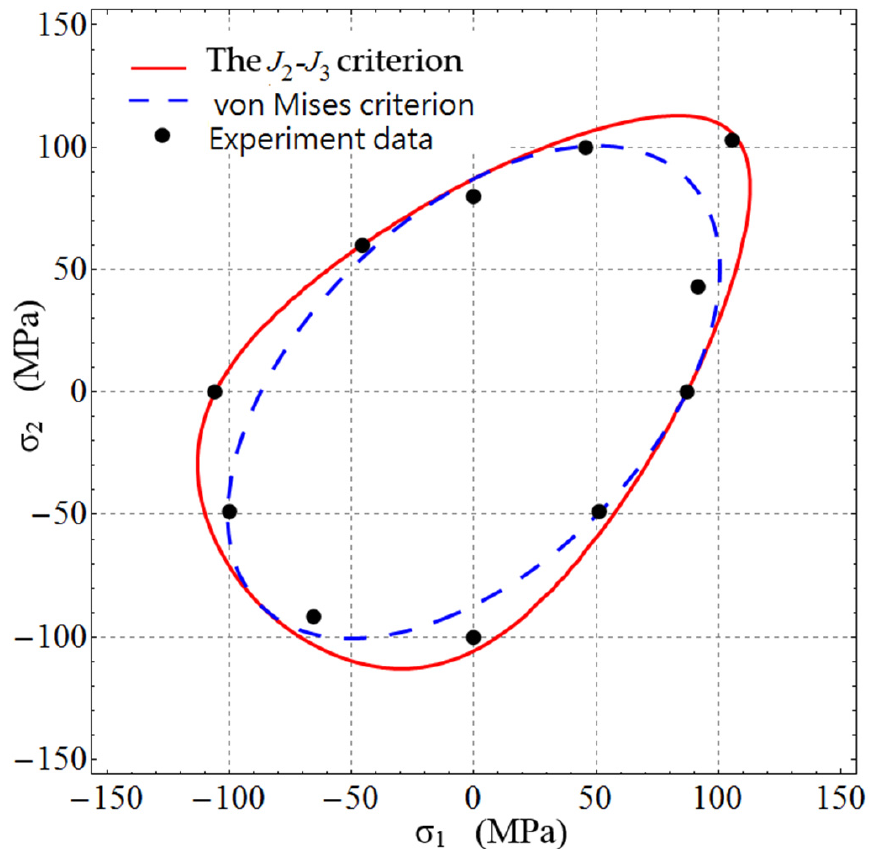
Figure 3. Comparison of experimental results and the theoretical initial transformation onset sur- faces for Cu-Al-Be SMA in the ( σ 1 , σ 2 ) plane at 35 ◦ C predicted by the J 2 - J 3 criterion and the von Mises criterion.